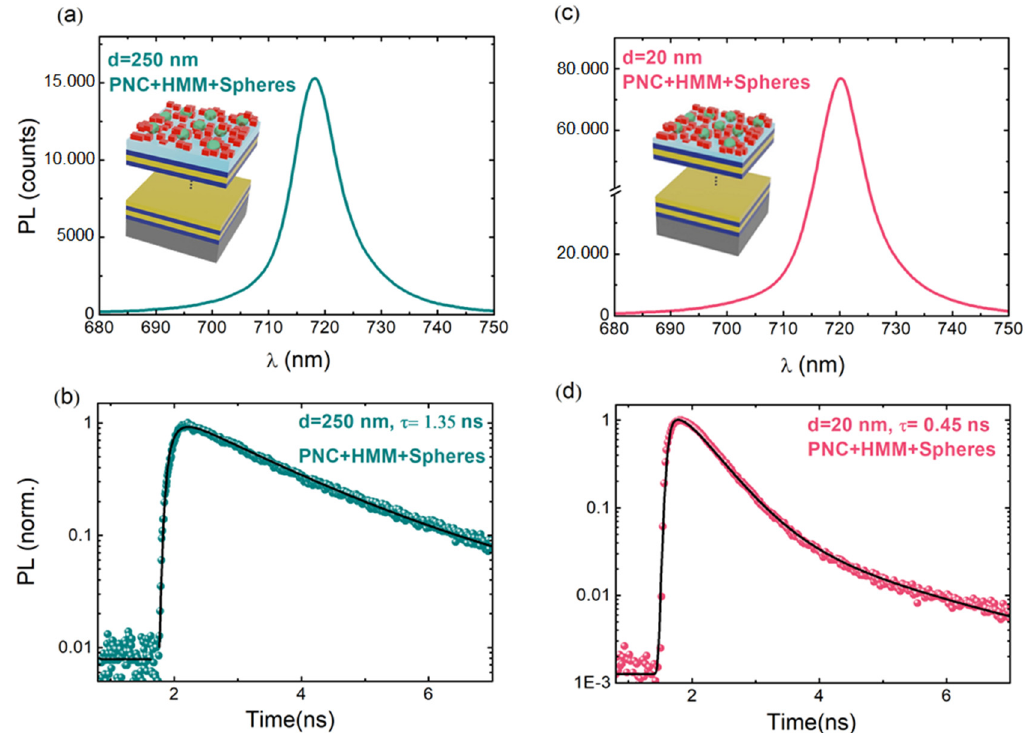
Figure 5. ( a , c ) The effect of TiO 2 nanospheres (270 nm in diameter) incorporated into HMM structures with d = 250, 20 nm spacer layers on the PL emission of CsPbI 3 PNCs. ( b , d ) PL transients of the same PNCs corresponding to PL peak wavelengths of spectra in ( a , c ), respectively. All measurements were performed at 15 K.